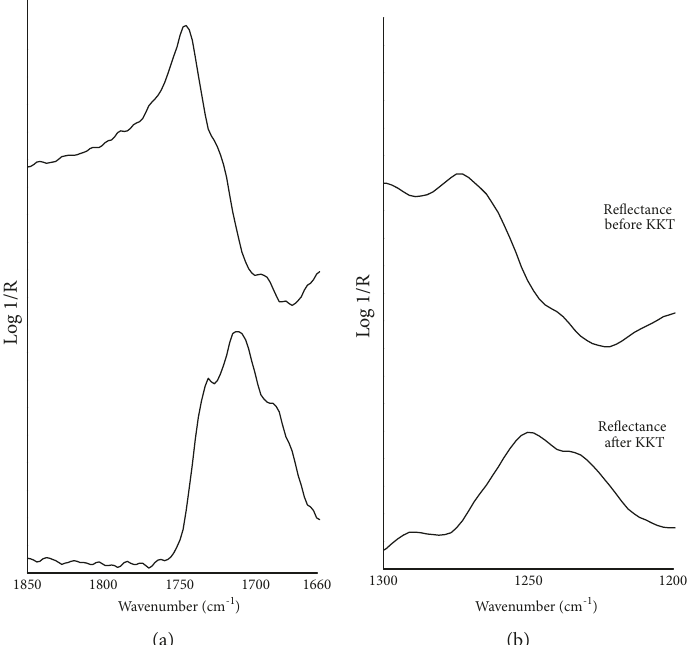
Figure 9: FTIR total reflection mode spectra of shellac before and after the KKT correction in the regions of (a) C=O stretching bands and (b) C-O stretching